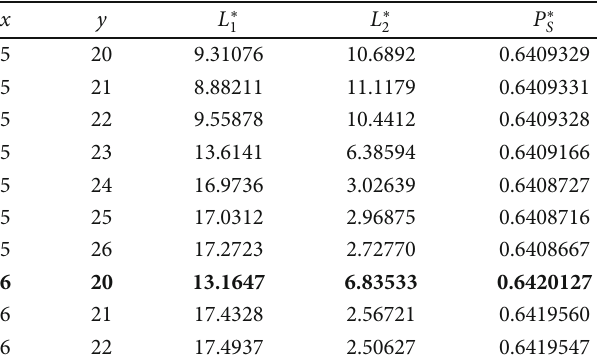
Table 4: Model simulation